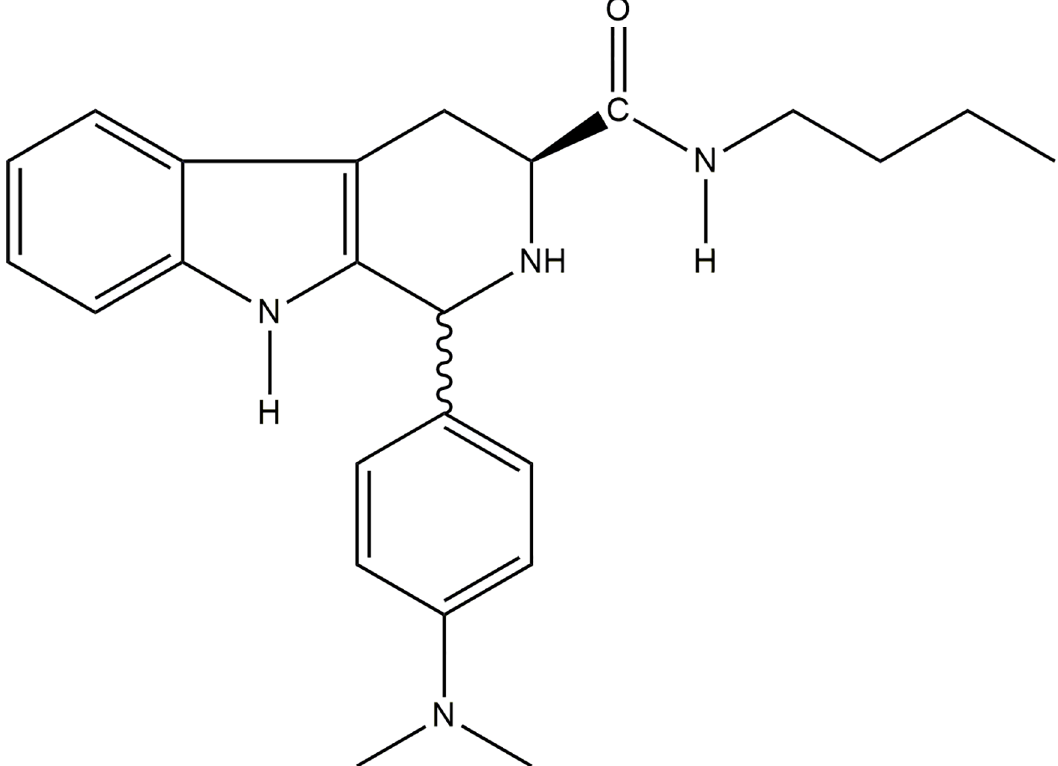
Fig 1. Chemical structure of N -butyl-1-(4-dimethylamino)phenyl-1,2,3,4-tetrahydro- β -carboline-3-carboxamide (C4).